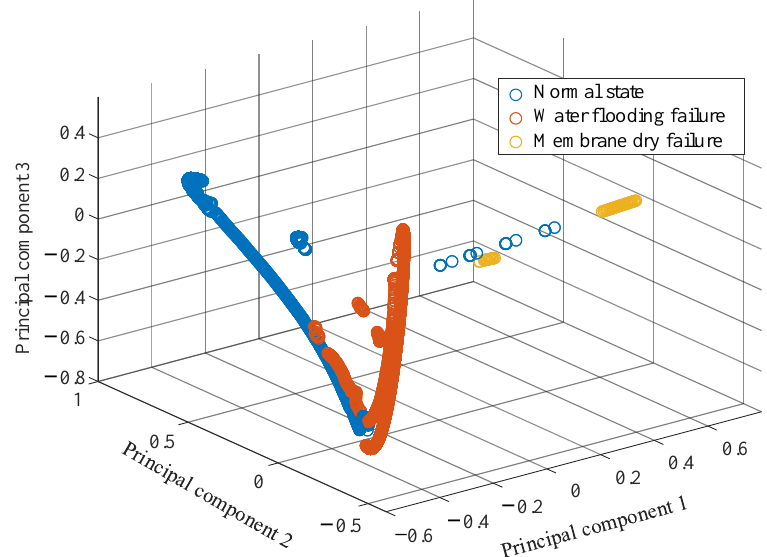
Figure 7. Visual views of the first three features of KPCA. The data samples of the health status characteristics after dimension reduction are shown in Table 3. Given the large amount of sample data, only part of the sample data of health status is listed. A total of nine groups of three health states are presented here. Table 3. Characteristic data with KPCA dimension reduction. Type